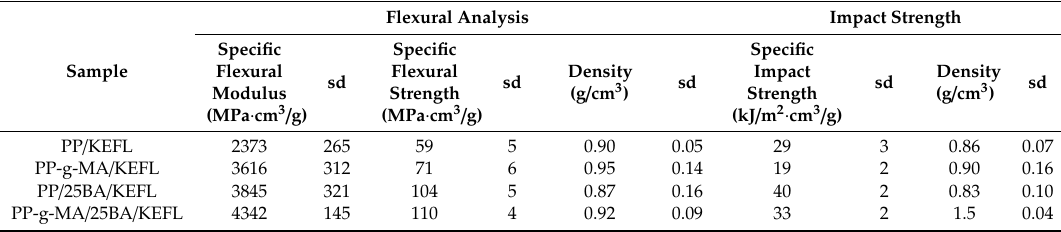
Table 7. Flexural and impact energy absorption analysis of PP and PP-g-MA composites.